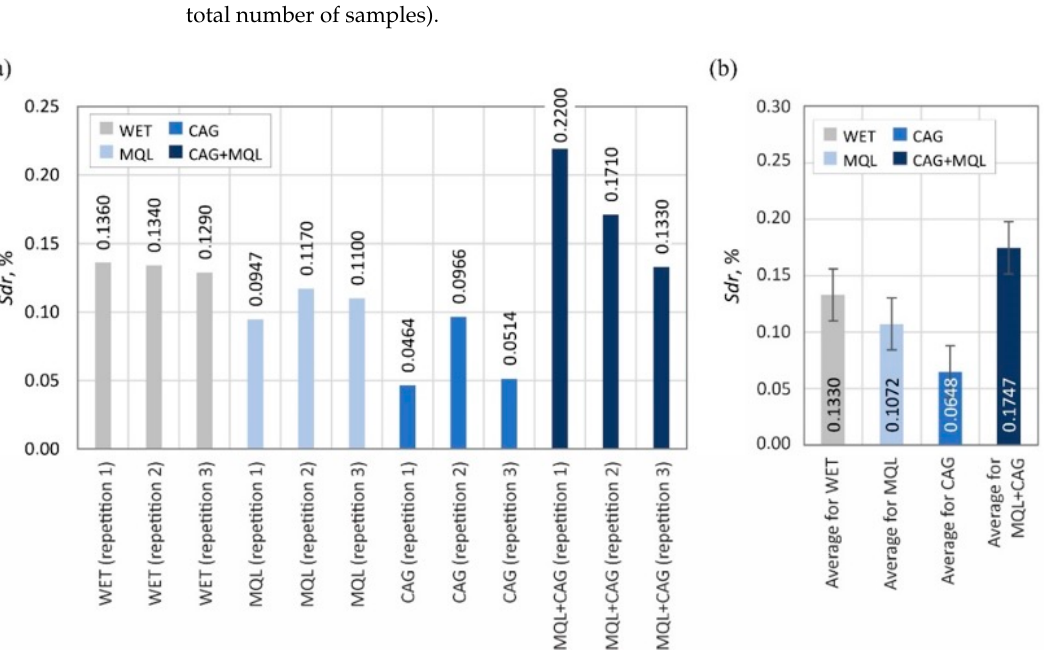
Figure 14. Chart of changes in the bearing index Sbi : ( a ) results for the twelve blades selected for the surface texture measurements; ( b ) mean values of the parameters divided by cooling and lubrication methods of the grinding zone used during the shaping of the blades (error bars represent the standard error equal to the standard deviation σ divided by the square root of the total number of samples). The results obtained from the analysis of selected surface texture parameters showed that changing the cooling and lubrication conditions of the machining zone in the grinding process of planar knife blades significantly affects the height of the shaped summits (amplitude parameters Sa and St ), as well as the associated volumetric (parameter Smvr ), spatial (parameters Sds and Str ), hybrid (parameters Sdq and Sdr ) and functional (parameter Sbi ) features. The results of the measurements lead to the conclusion that the use of the WET flooding method and MQL allowed the shaping of blade surfaces with